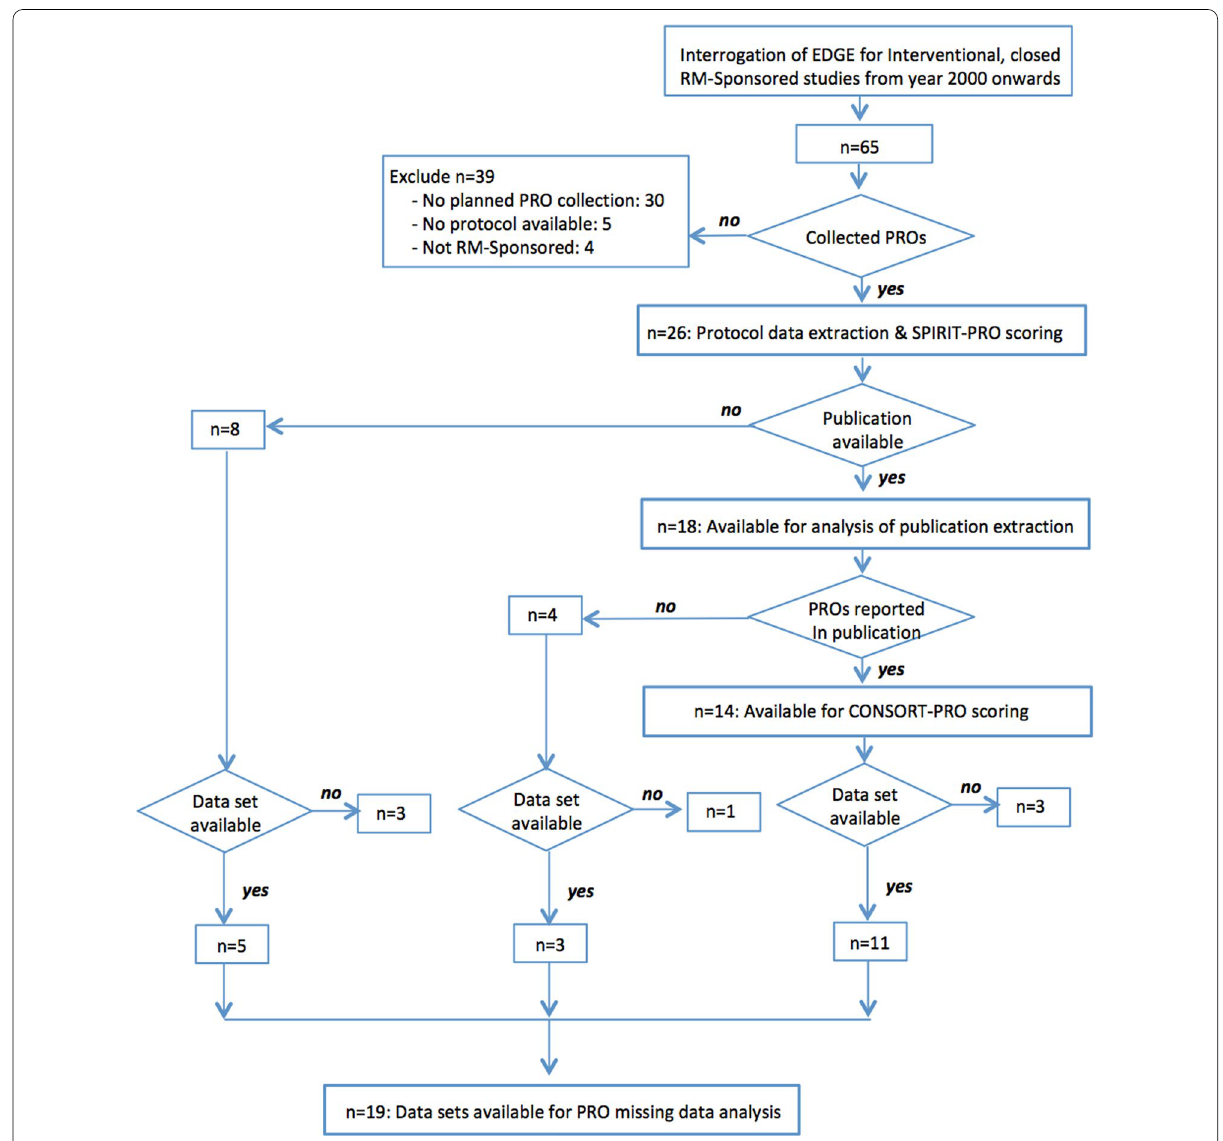
Fig. 1 CONSORT diagram: data